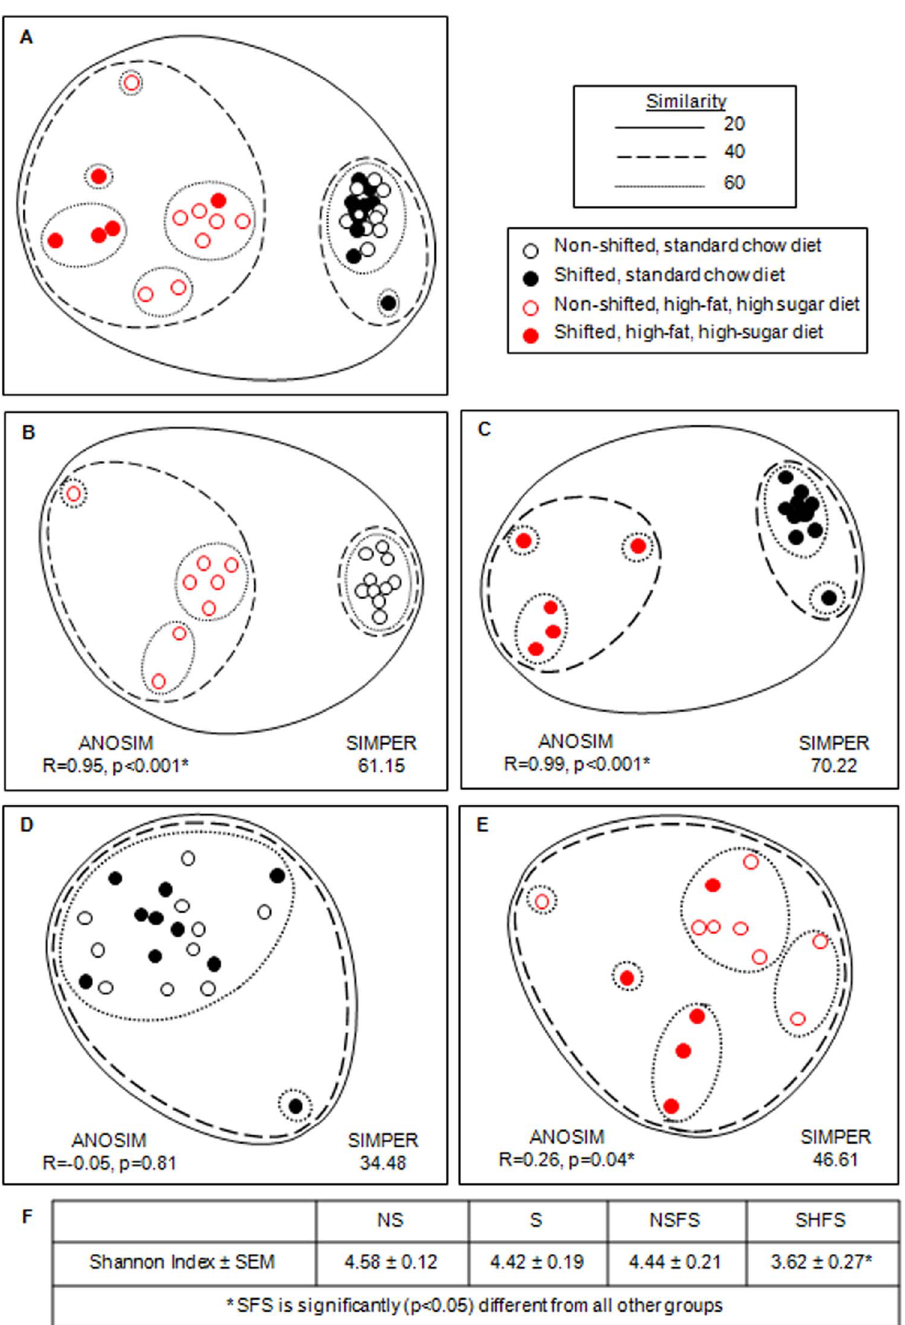
Figure 2. Effect of diet and circadian rhythm disruption on mouse gut microbial communities. The non-metric multidimensional scaling (NMDS) plot demonstrates the effect of treatments on the overall mouse fecal microbial community structure, as assessed by bacterial small subunit ribosomal RNA gene amplicon sequencing . The NMDS plot is based on sample-standardized and square-root transformed abundance data. The NMDS plot and the hierarchical cluster overlay are based on a resemblance matrix calculated using S17 Bray-Curtis similarity. 2D stress values ranged from 0.04 to 0.17. ANOSIM: Analysis of similarities. SIMPER: Similarity percentages.